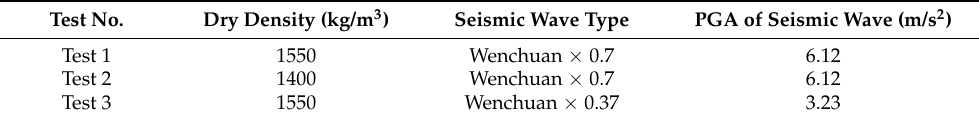
Table 1. Dry density of the coral sand foundation and peak acceleration in the test. Test No.